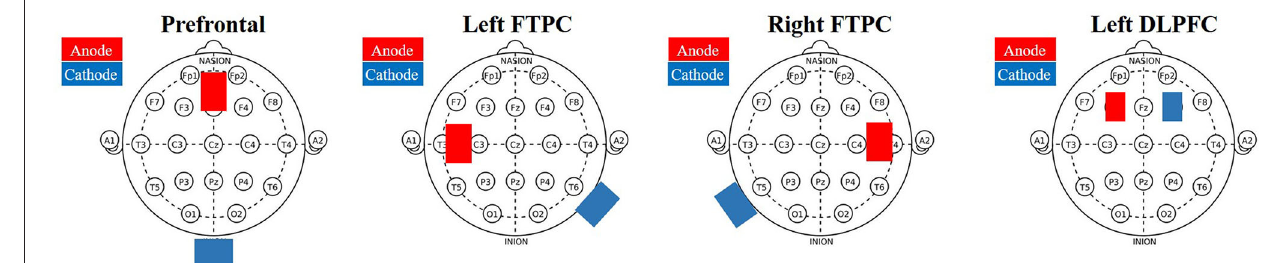
FIGURE 2 | Transcranial direct current stimulation electrodes